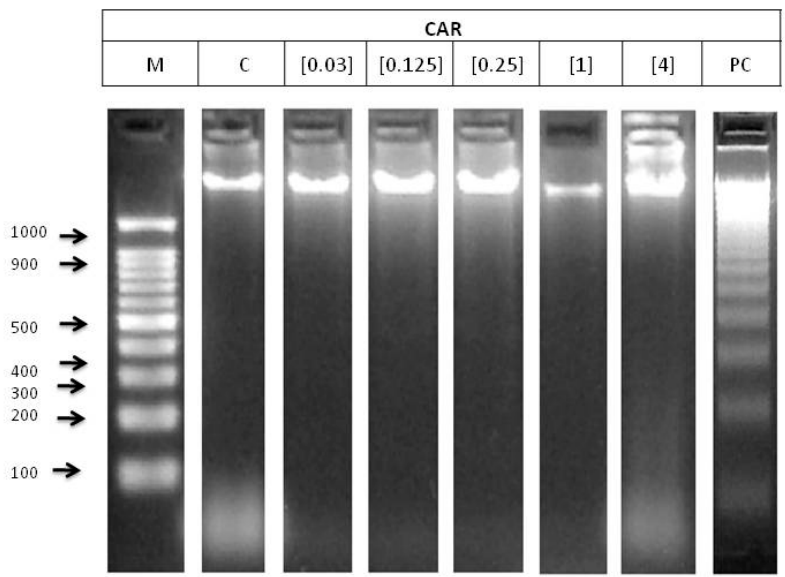
Figure 3. Internucleosomal DNA fragmentation after 5 h of HL-60 cells treated with CAR. Letters M and C mean weight size marker and negative control (RPMI), respectively, and lyophilised blond beer (62.5 mg / mL) has been used as a routine positive control